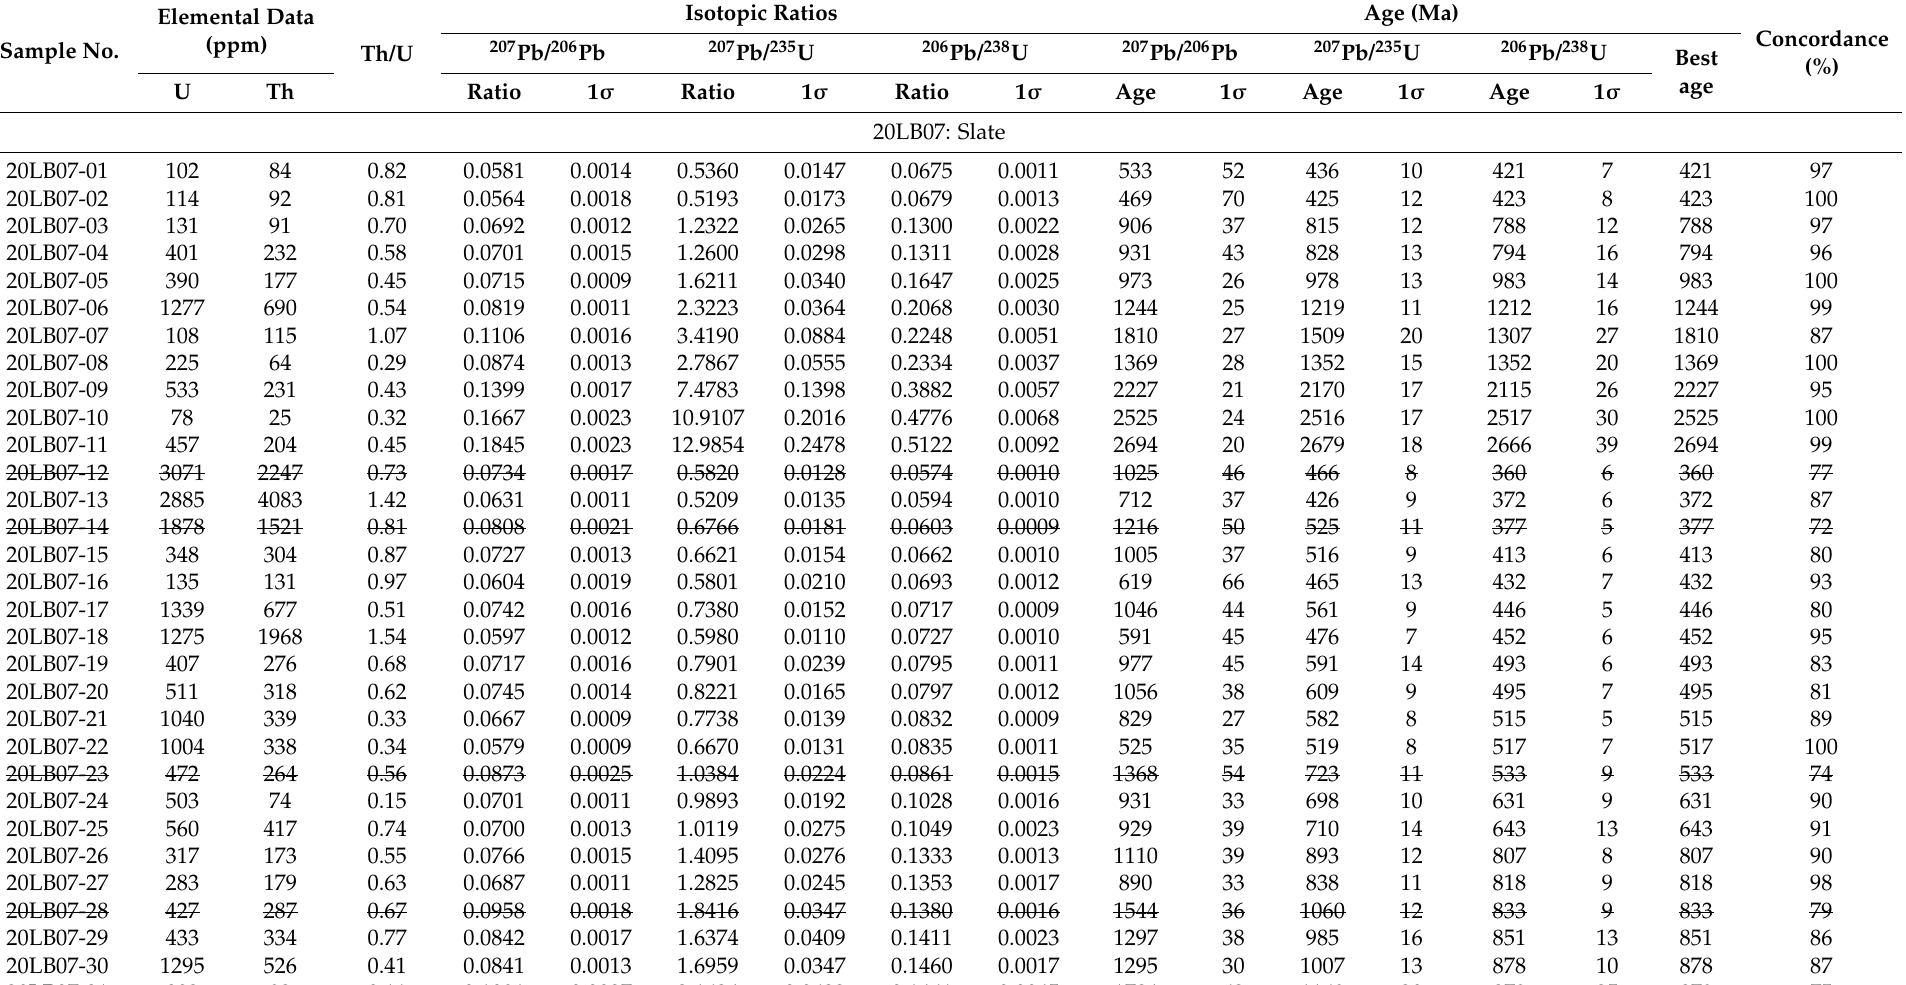
Table 1. Zircon LA-ICP-MS U–Pb data of the Liba Group. Ages of zircon grains (<1.0 Ga) are quoted using 206 Pb/ 238 U ages, whereas older grains are based on